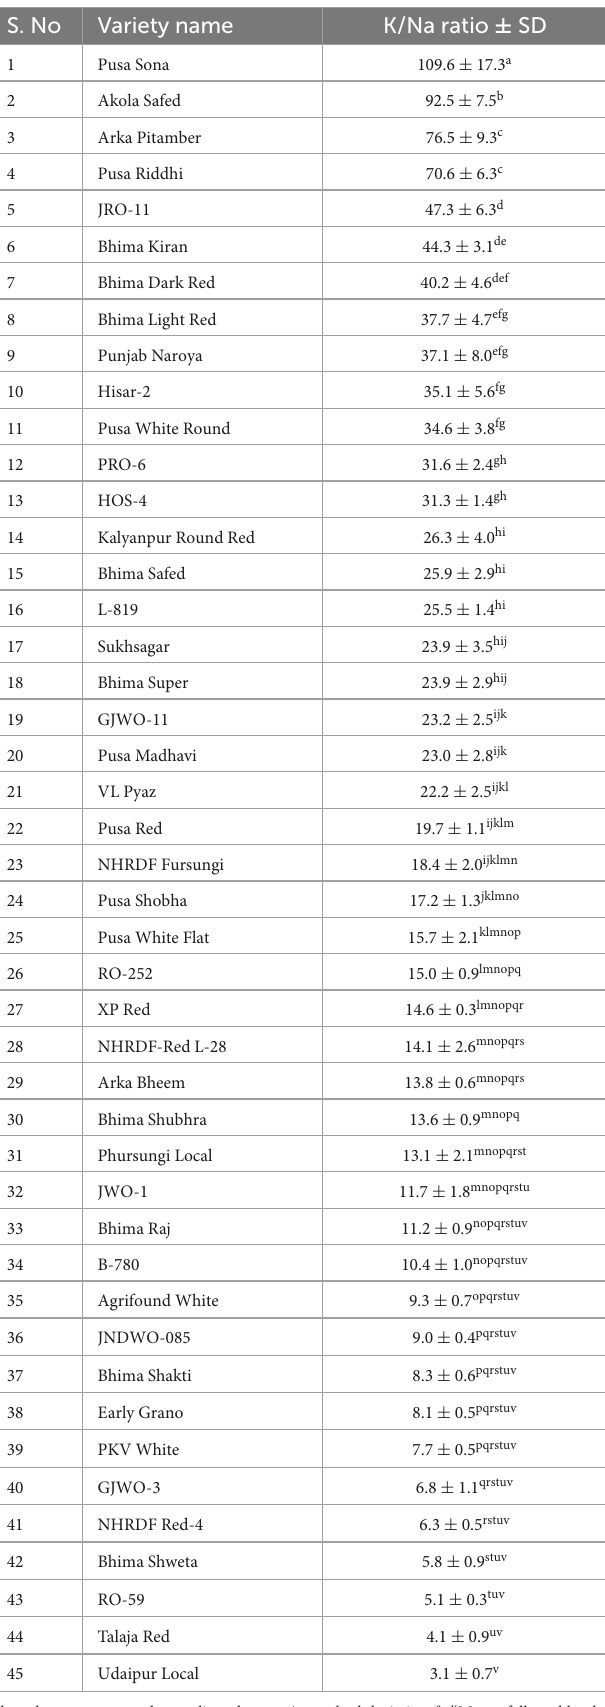
TABLE 5 Potassium/sodium ratio (K/Na ratio) in short-day Indian OP commercial varieties grown under the trans- gangetic plains of India. S.